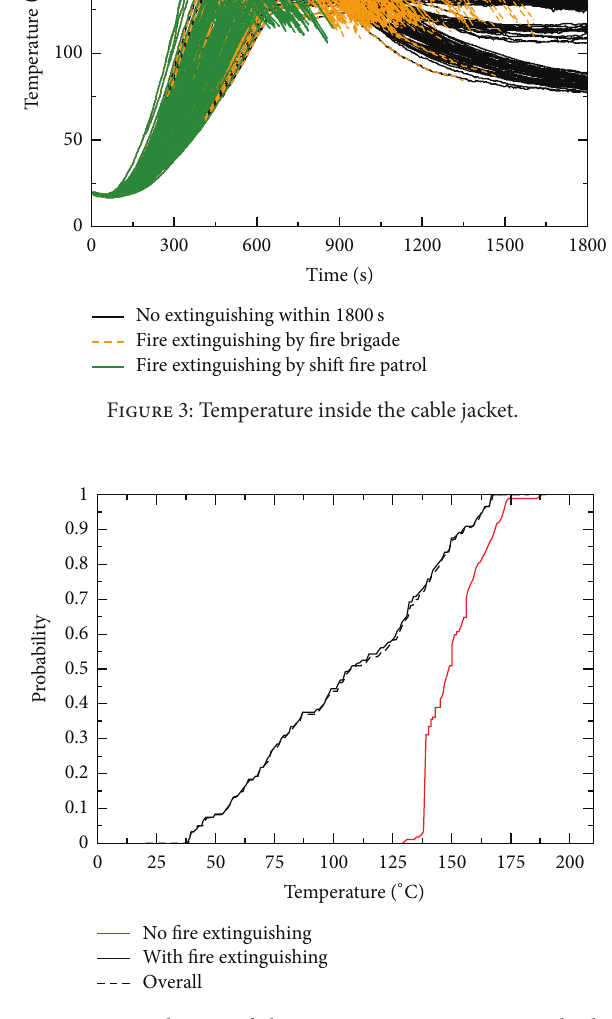
Figure 4: Distribution of the maximum temperature inside the cable